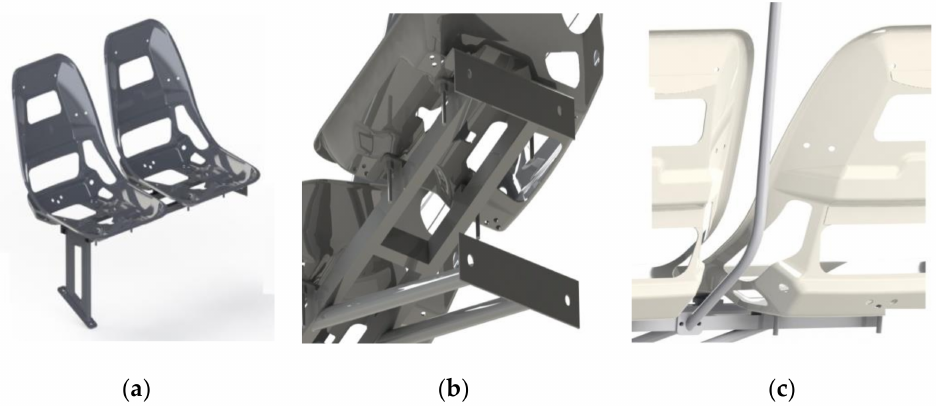
Figure 6. Three-dimensional model of a seat with a stand ( a ), a side control fixing ( b ), and a handrail attached to the roof frame ( c